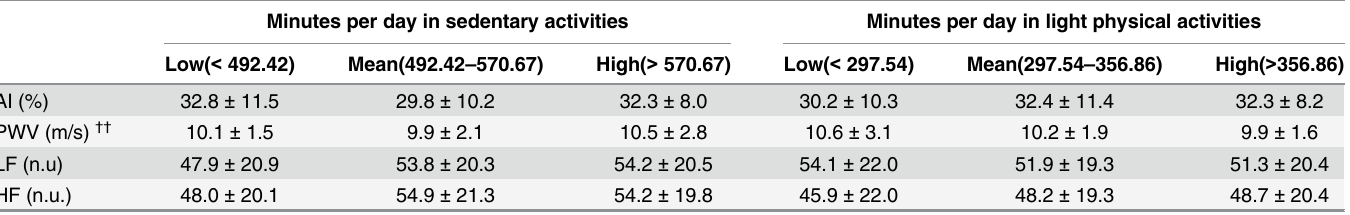
Table 2. Comparison of arterial stiffness and cardiac autonomic modulation among tertiles of minutes spent in sedentary activities and light phys- ical